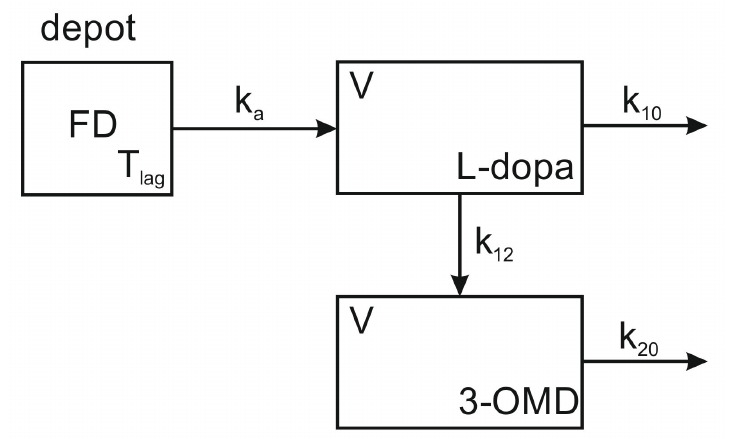
Figure 1. Pharmacokinetic model for the drug-metabolite system